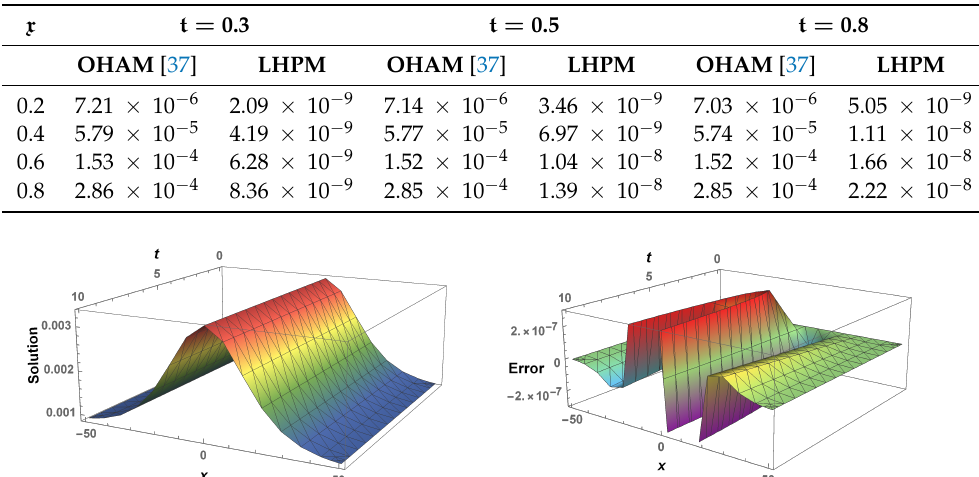
Table 9. Comparison of LHPM and OHAM errors in the Kaup–Kupershmidt model (Example 4) at different t when β = 1, λ = 0.1, w = 1, ρ = 2.5 and µ = 0.